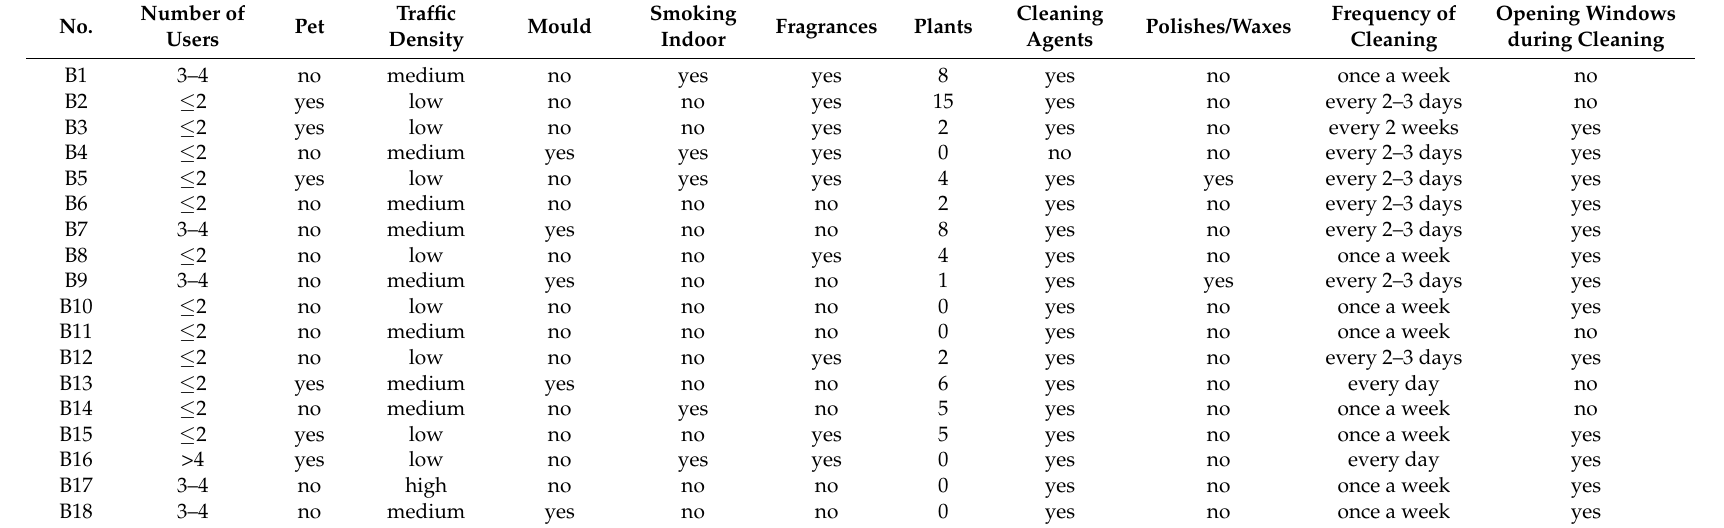
Table A2. Basic information about the apartments—Part